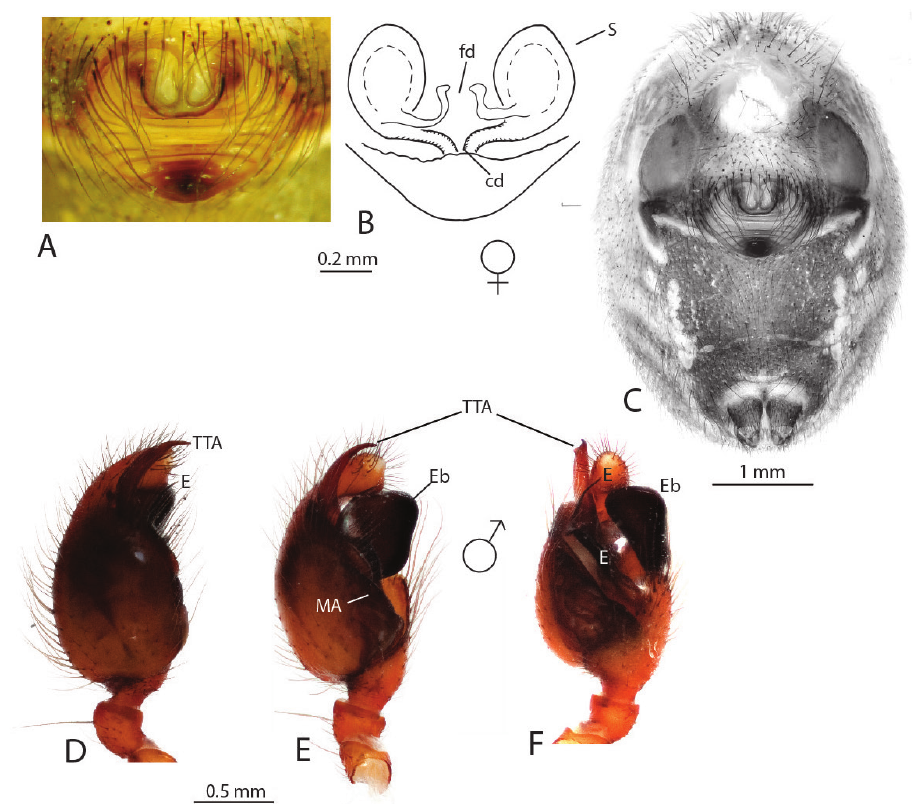
Figure 5. Anelosimus nazariani : A epigynum, ventral B epigynum, dorsal; C, female abdomen, ventral D–F male palp dorsal, mesal,